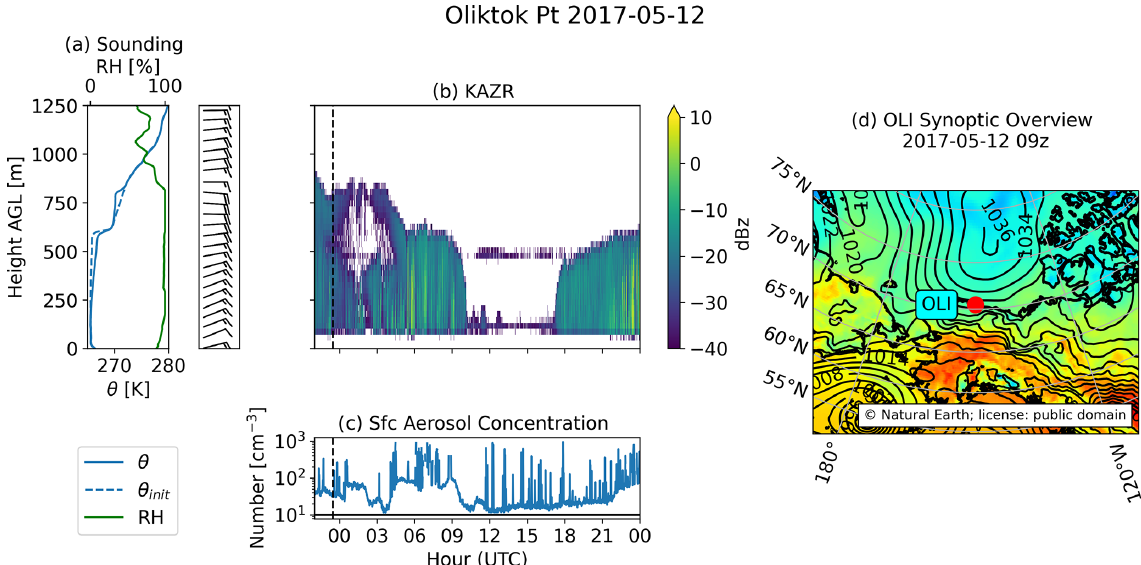
Figure 2. Overview of observations for Oliktok Point, AK (OLI). (a) Potential temperature ( θ ; blue) and relative humidity (green) and wind barbs from a sounding at 23:30UTC on 11 May 2017. (b) KAZR (radar) general mode reflectivity (dBz). (c) Surface aerosol concentration (CPC fine). (d) ERA5 reanalysis mean sea level pressure (contours) and 2m temperature (color shading) for 12 May 2017 at 09:00UTC. The dashed vertical line in panels (b,c) represent the time at which the sounding was taken. The solid horizontal line in panel (c) represents a surface aerosol concentration of 10cm − 1 . For OLI alone, θ init in panel (a) represents the profile used for the model initialization.